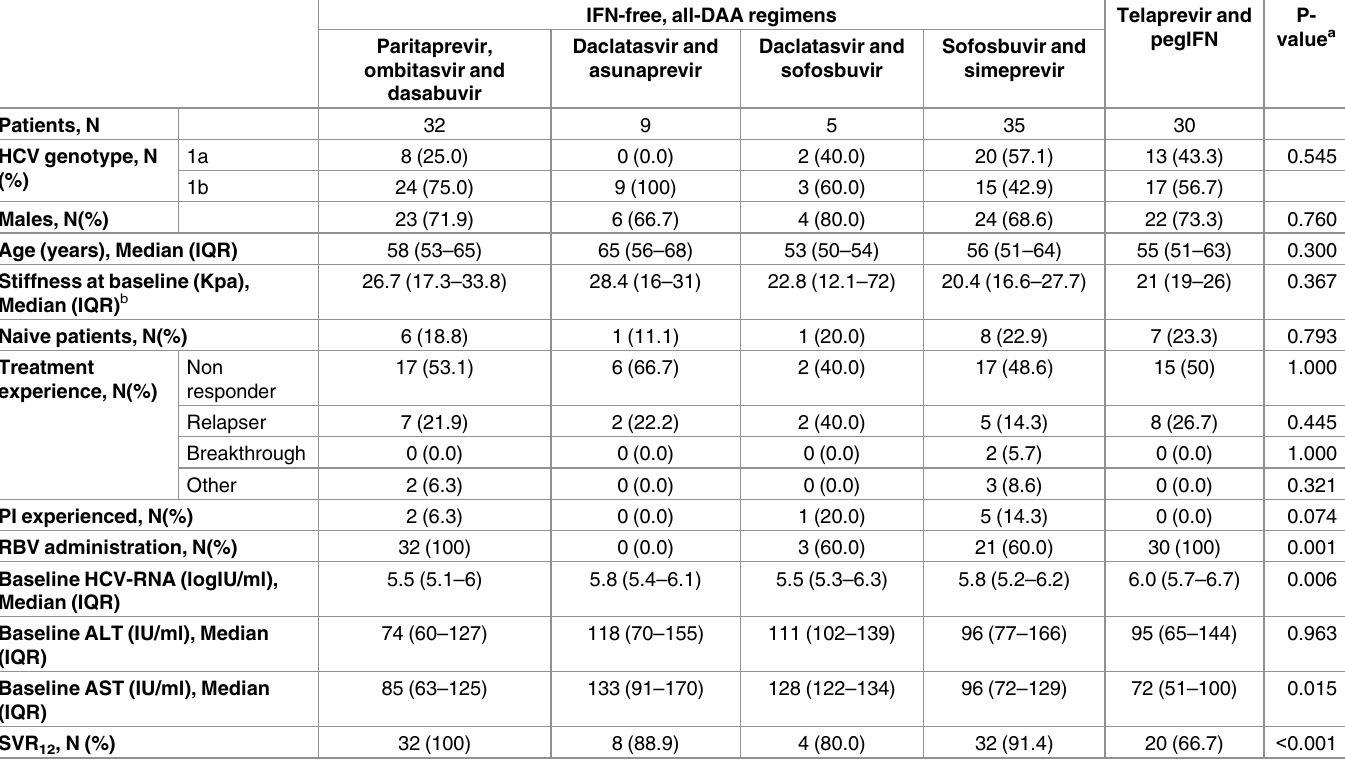
Table 1. Characteristics of the study population.